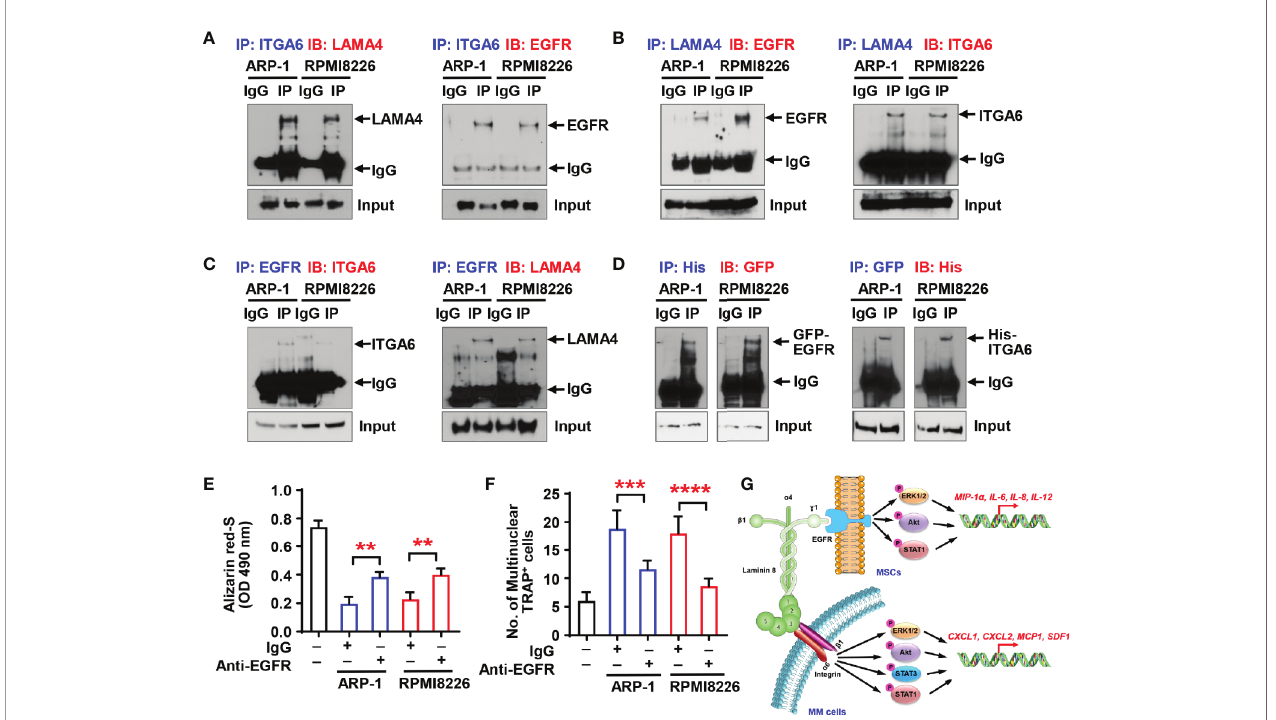
FIGURE 6 | Myeloma cell integrin a 6 regulates osteoblast differentiation via the ITGA6-LAMA4-EGFR complex. (A – C) Co-immunoprecipitation of ITGA6 (A) , LAMA4 (B) or EGFR (C) in myeloma cells ARP-1 or RPMI8226 cocultured with MSCs. (D) Myeloma cells were transfected with His-tagged integrin a 6 and MSCs were transfected with GFP-tagged EGFR. Coimmunoprecipitation of His (left panel) or GFP (right panel) in myeloma cells and MSCs coculture system. (E) Shown is the summarized data of Alizarin red S staining of MSCs, which were pre-treated with IgG control or 2 µg/ml of anti-EGFR neutralize antibody and then co-cultured with or without ARP-1 or RPMI8226 cells for 14 days. (F) Shown is numbers of multinuclear ( ≥ 3) TRAP + cells in preOCs that were pre-treated with IgG control or 2 µg/ml of anti-EGFR neutralize antibody and then co-cultured with or without ARP-1 or RPMI8226 cells for 7 days. Data shown as averages ± SD is a representative of three independent experiments. ** P < 0.01. *** P < 0.001. **** P < 0.0001. P values were determined using one-way ANOVA. (G) Depiction of integrin a 6-mediated signaling pathways in myeloma cells and